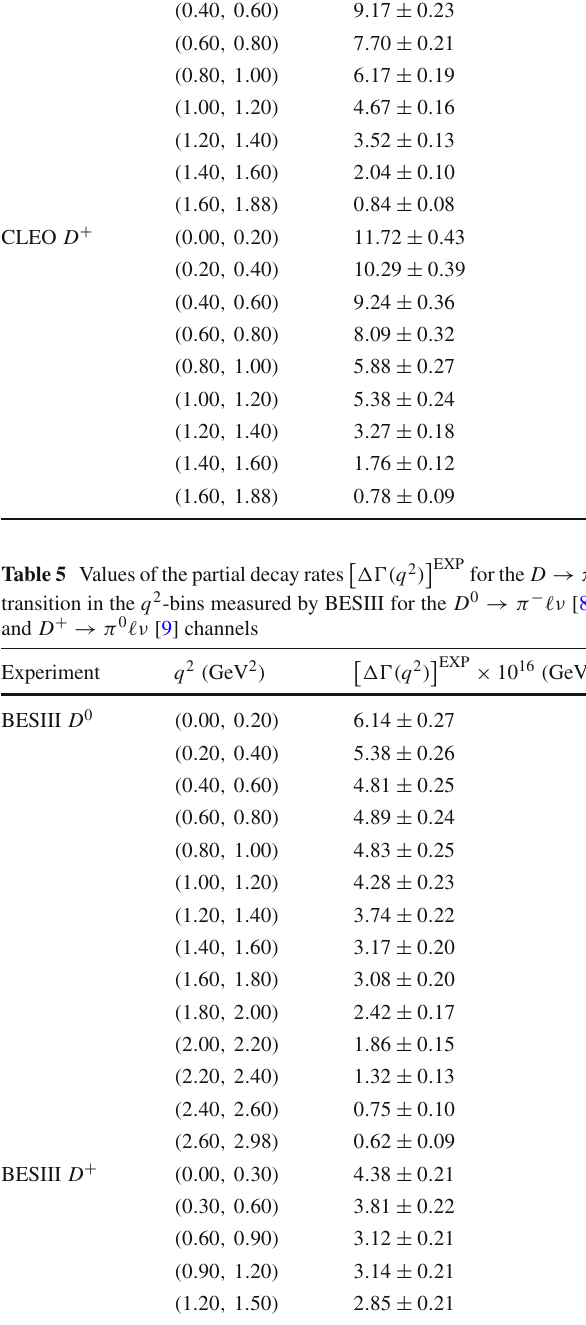
Table 1 Values of the partial decay rates transition in the q 2 -bins measured by BABAR [5] Experiment q 2 ( GeV 2 ) BABAR